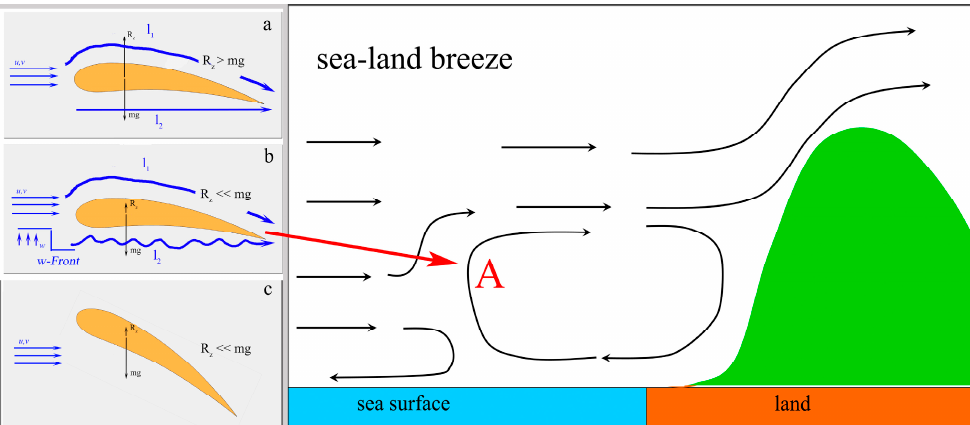
Figure 1. In the left panel: the streamlined processes ( u,v ) on a classical wing profile before an interaction with the w -Front ( a ); over the step of the w -Front ( b ); and after an interaction with the w -Front ( c ). In the right panel: sea-land circulation in the presence of mountains on the seacoast. A—atmospheric local vertical front.